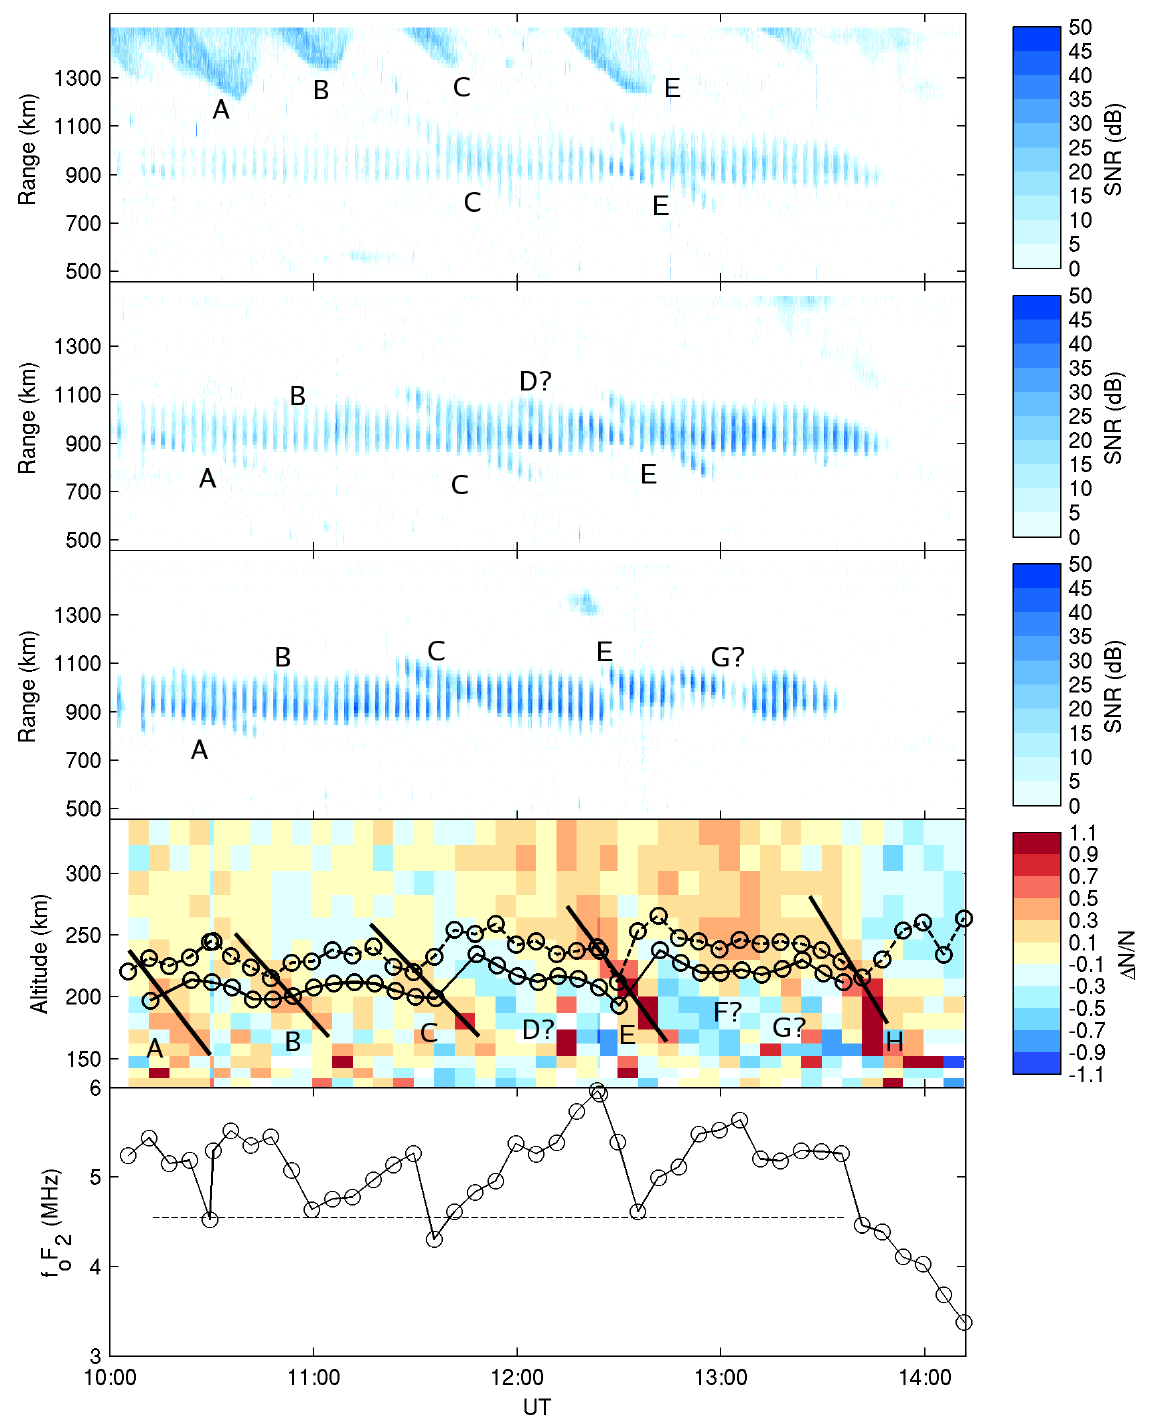
Fig. 2. Top panel: range-time-intensity (RTI) plot of CUTLASS radar backscatter signal-to-noise ratio (SNR) at 13.2MHz. Second panel (from top): as top panel, but at 15.1MHz. Third panel: as top panel, but at 18.0MHz. In these three panels, the range is the group range measured by the radar, not ground range. Fourth panel: relative electron density perturbations measured by the EISCAT UHF radar in the field-aligned direction. The solid black line indicates the altitude of the HF pump-enhanced ion line and the dashed black line indicates the altitude of the F-region density maximum. Bottom panel: the solid line indicates the F-region O-mode critical frequency. The dashed line is the HF pump